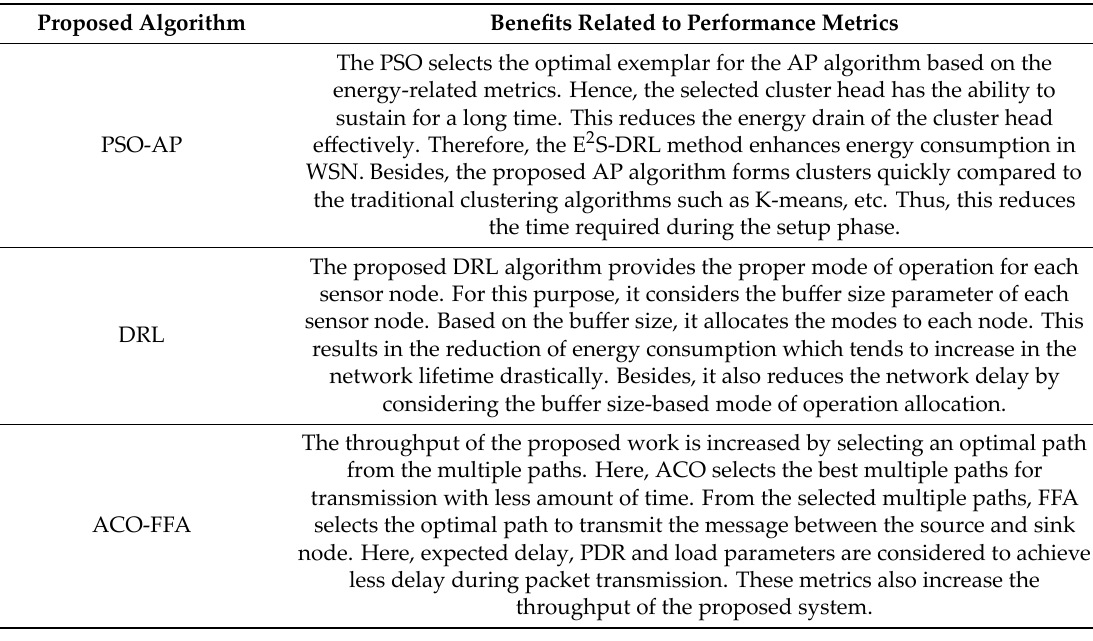
Table 4. Benefits of the proposed algorithms.